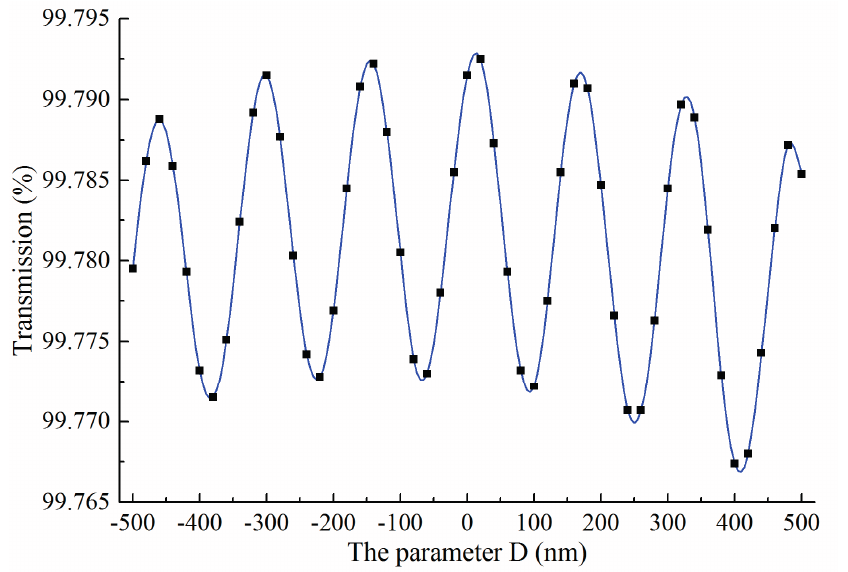
Figure 8. The bend efficiency as a function of the Goos-Hanchen shift compensation (parameter D ). There is an oscillatory variation, but the amplitude is very